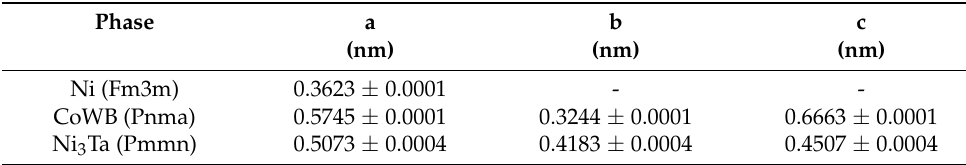
Table 1. The lattice constants of the observed phases.